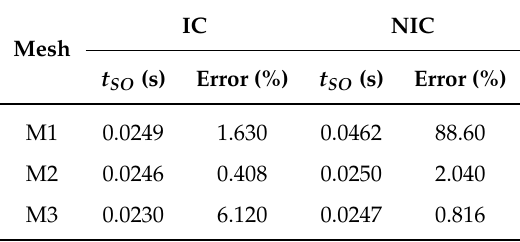
Table 4. Comparison of the switch-over time obtained for the incompressible formulation, considering both interface compression (IC) and neglecting IC (NIC) variations. The analytical reference value calculated from Equation (17) is t SO = 0.0245